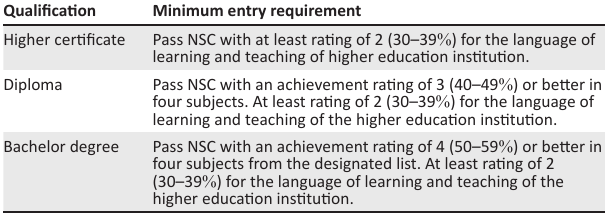
TABLE 2: Criteria for higher certificate, diploma and degree